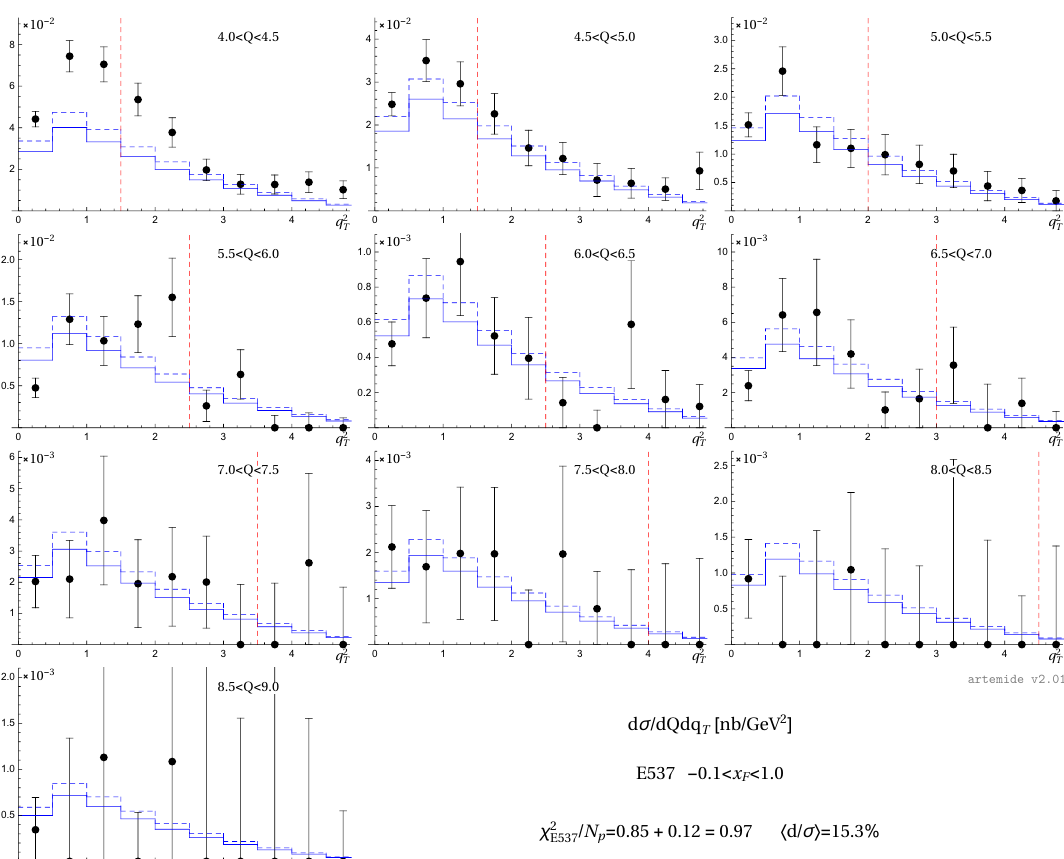
Figure 4 . Comparison of the theory prediction (solid line) to E537 di(cid:11)erential in Q . The dashed line is the theoretical prediction after the addition of systematic shifts d i . The values of the (cid:31) 2 and d i are calculated for the full set of data with 8% correlated error. The vertical dashed line shows the estimation of the boundary for TMD factorization